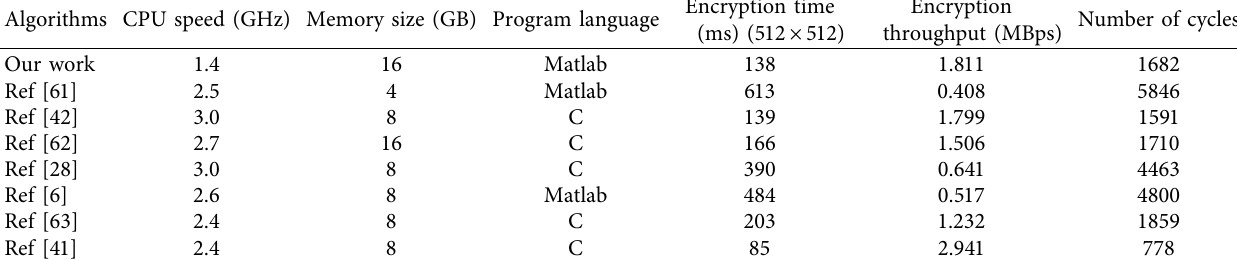
Table 8: Speed comparison.